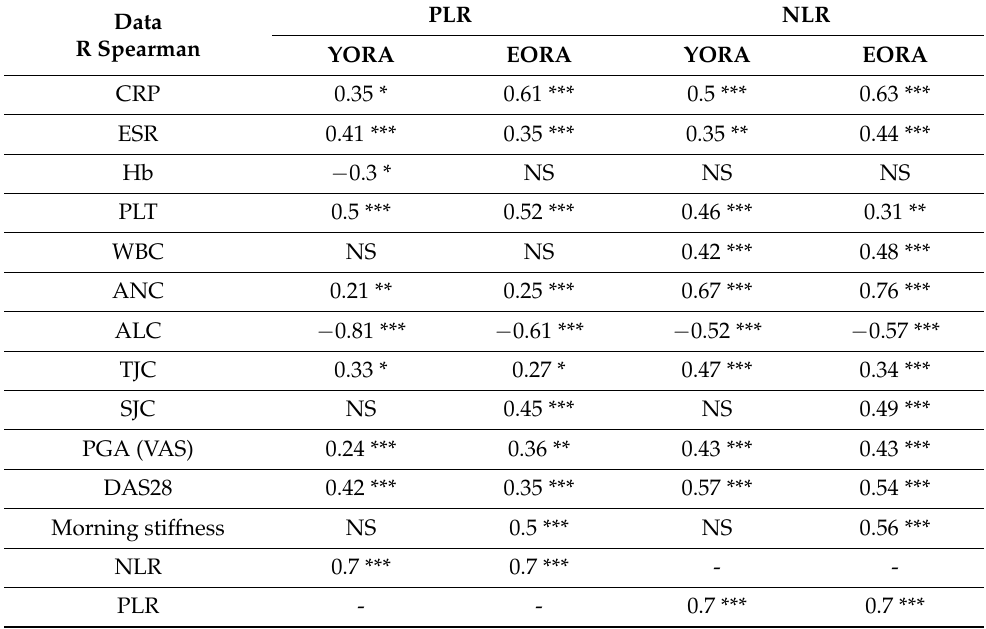
Table 4. Associations between hematological systemic inflammatory markers and disease activity parameters in YORA and